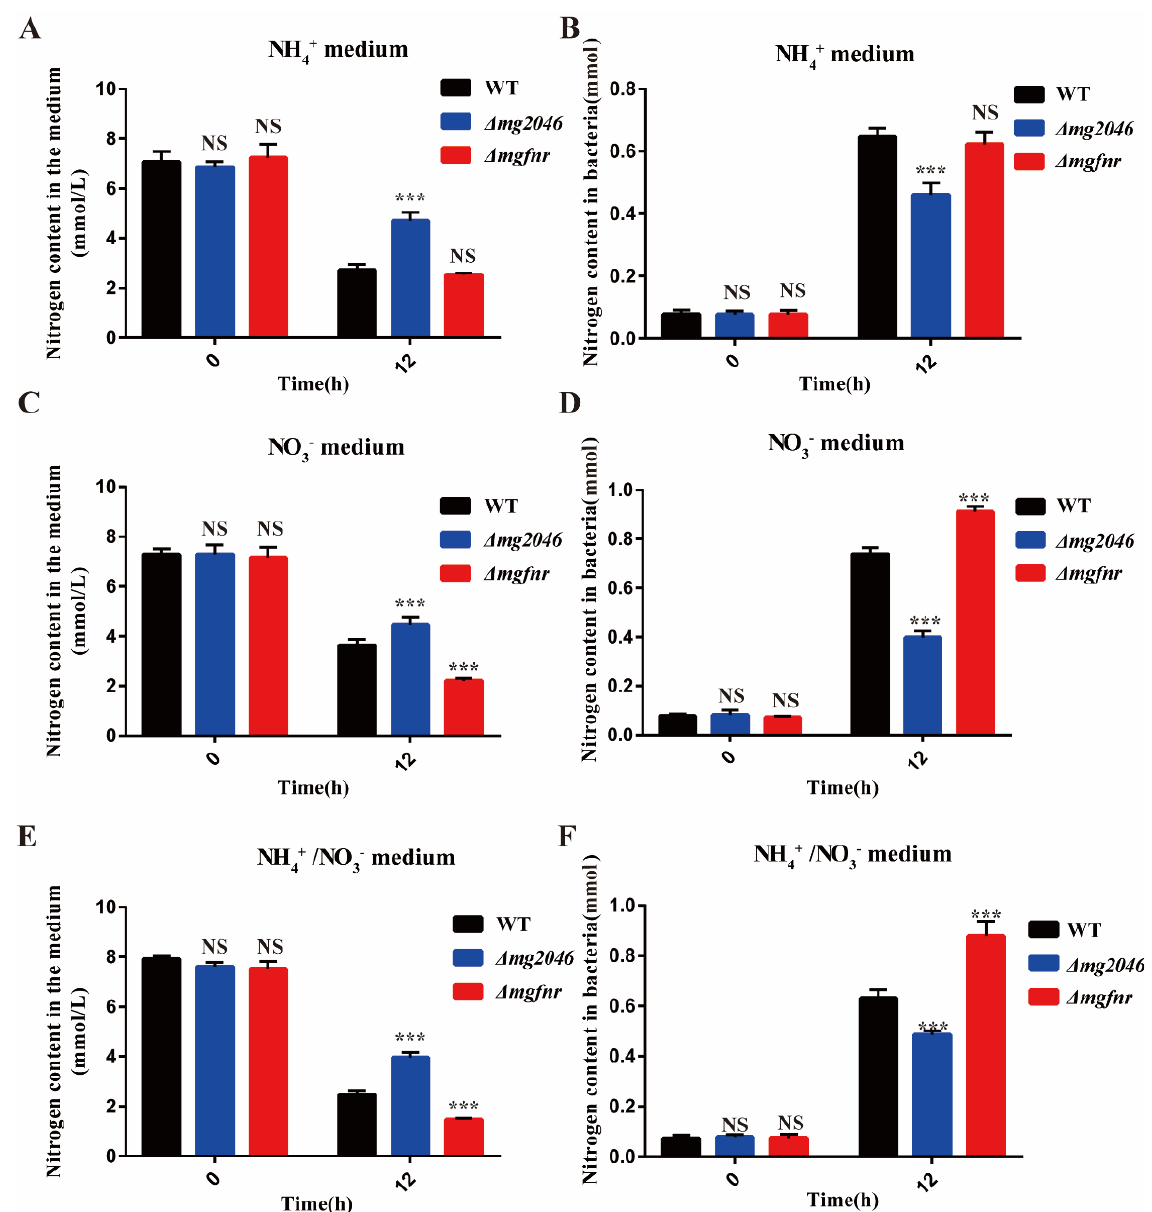
Figure 5. Total nitrogen content of media and bacteria for WT, Δmg2046 , and Δmgfnr . ( A ) NH 4+ medium. ( B ) Bacteria in NH 4+ medium. ( C ) NO 3 − medium. ( D ) Bacteria in NO 3 − medium. ( E ) NH 4+ /NO 3 − medium. ( F ) Bacteria in NH 4+ /NO 3 − medium. NS: no significant difference ( t -test). *** p < 0.001. Error bar: SD from three replicate experiments.